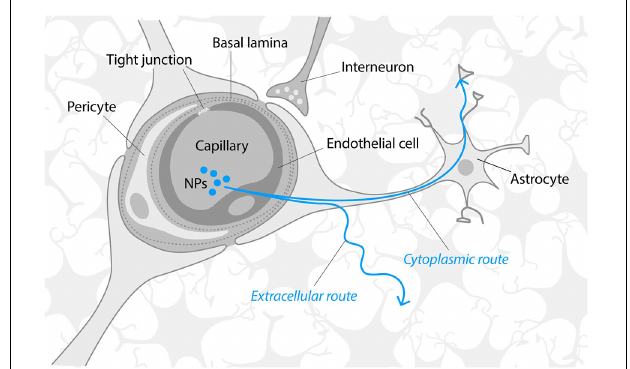
FIGURE 3 | Schematic structure of the blood–brain barrier. Modified from Abbott et al. (2006) and Lau et al. (2013). Neurotrophic factors and nanoparticles are mainly transported through the BBB via receptor-mediated transcytosis or endocytosis. Once across the BBB, NTFs, and NPs must traverse the extracellular space (ca 40 nm microenvironment formed by gaps between brain cells) that limits the diffusion of molecules that are significantly larger than 40 nm or/and bind to the extracellular matrix. It has been suggested that NPs may also follow the alternative, “speedy cytoplasmic route” through the brain tissue, assumingly via the connections of astrocytes (Kreuter, 2014).